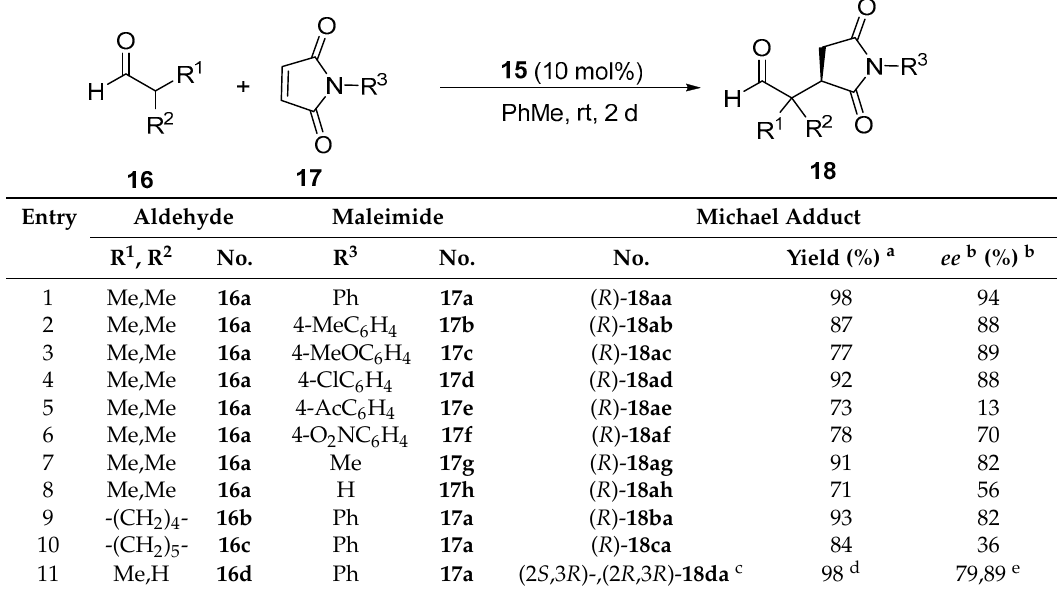
Table 2. Enantioselective Michael addition of aldehydes to maleimides organocatalyzed by 15 .